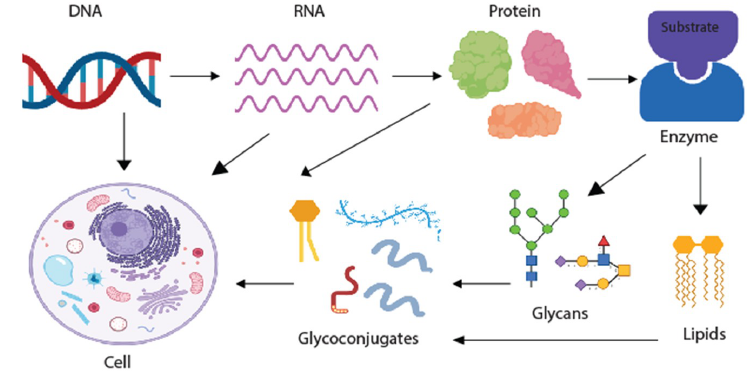
Figure 2. The importance of glycans can be conceptualised as an extended model of the central dogma. Created with BioRender.